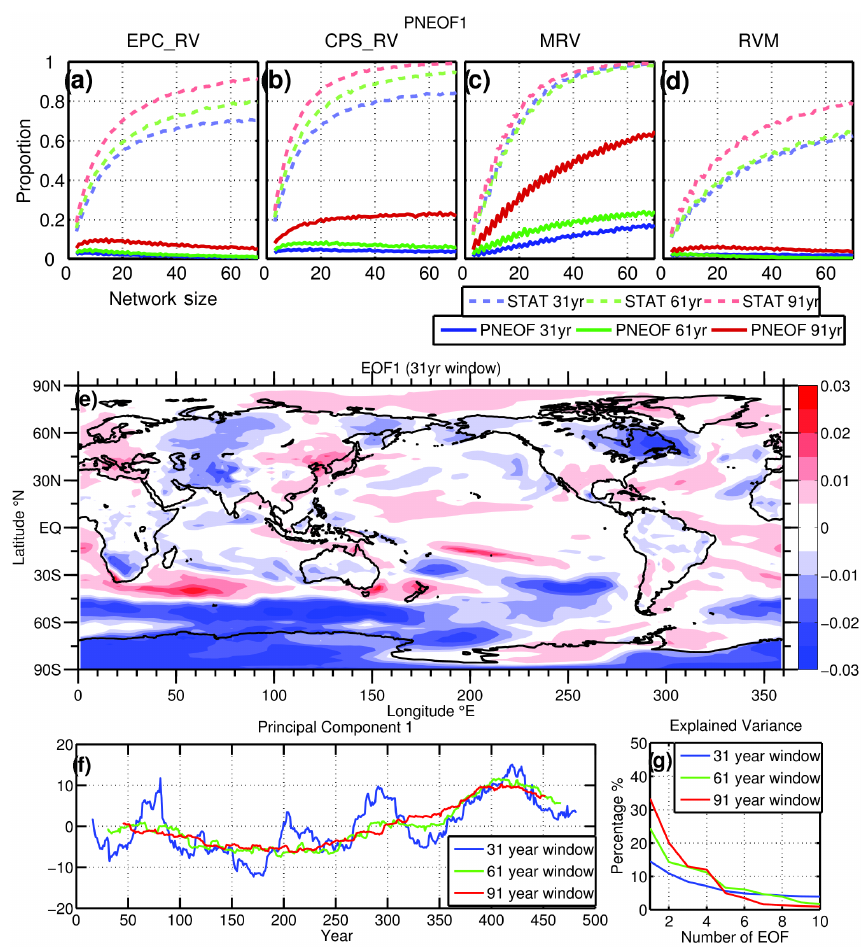
Figure 7. (a – d) The reconstructions from the PNEOF1 (solid) and STAT ntrop_ts (dashed) experiments using different reconstruction methods. The proportion of skilful reconstructions (out of the 10000) is shown for calibration windows of 31- (blue), 61- (green) and 91-year length (red), plotted against proxy network size ( x axis). Skilful is defined as the reconstruction explaining greater than 50% of the variance of the model ENSO reconstruction. (e) The spatial map of the leading empirical orthogonal function (EOF) of running correlations calculated between TS at each grid point and ENSO (with a window length of 31 years). The spatial structure of this EOF is quantitatively similar to the first EOF with running correlation window lengths of 61 (spatial r = 0 . 86), and 91 (spatial r = 0 . 84) years. (f) The leading principal components of the leading EOF with running correlation window lengths of 31 (blue), 61 (green) and 91 (red) years. The year values correspond to the centre of the windows. (g) The variance explained by the first 10 EOFs, for the three different window sizes (see inset